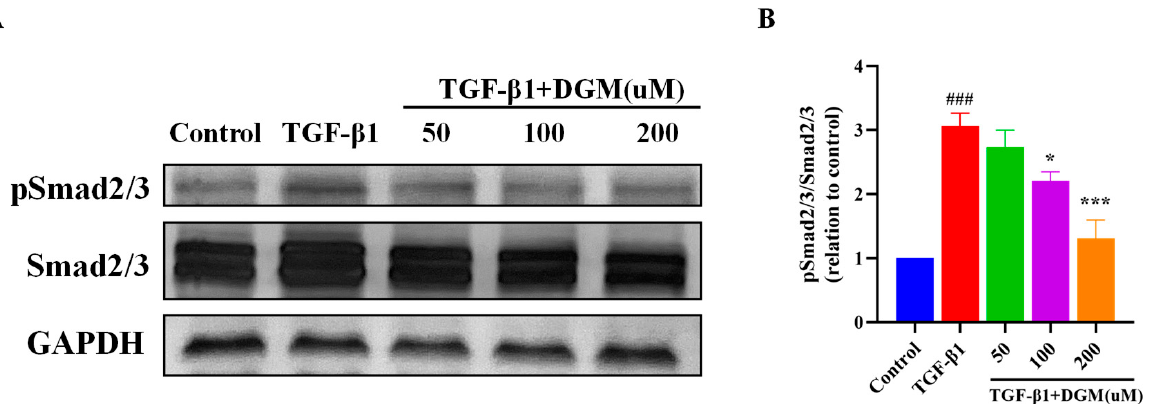
Figure 3. DGM inhibits the activation of the Smad signaling pathway stimulated by TGF- β 1. A549 cells were pretreated with DGM for 2 h, followed by TGF- β 1 (5 ng/mL) stimulation for an additional 6 h, and intracellular proteins were extracted for subsequent western blotting analysis. ( A ) Western blotting analyses of Smad2/3, pSmad2/3 protein expression in TGF- β 1-stimulated A549 cells stimulated with TGF-1. ( B ) Quantification of the pSmad2/3/Smad2/3 ratio. Data represent the mean ± SEM ( n = 3). ### p < 0.001 vs. control group; * p < 0.05, *** p < 0.001 vs. TGF- β 1 group.